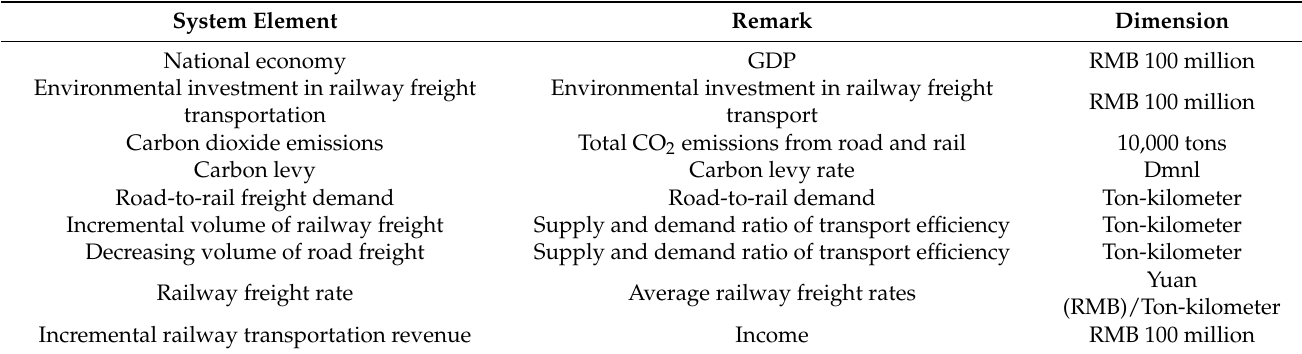
Table 1. System element